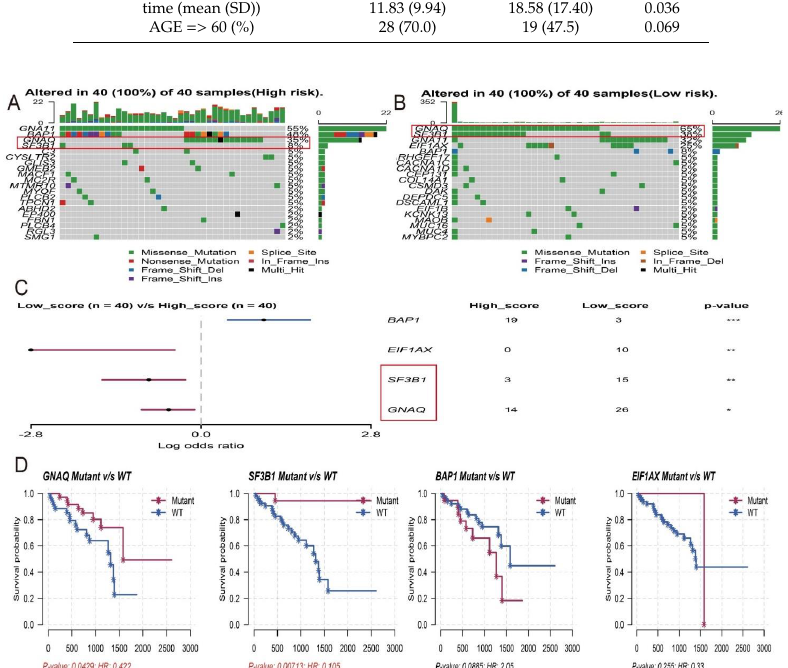
Figure 7. Differential landscape of somatic mutation burden between high and low risk groups. ( A ) The waterfall plots of the top 20 mutant genes in high risk group. ( B ) The waterfall plots of top 20 mutant genes in low risk group. ( C ) Forestplot suggested that three genes GNAQ, SF3B1 and EIF1AX which are highly mutated in low-risk group compared to high-risk group (*** p < 0.001, ** p < 0.01, * p < 0.05). (D) Kaplan–Meier overall survival curves of four different mutated genes. The mutant of GNAQ and SF3B1 have a longer survival time than the wild type. With log-rank P = 0.043 and log-rank P = 0.007 respectively.